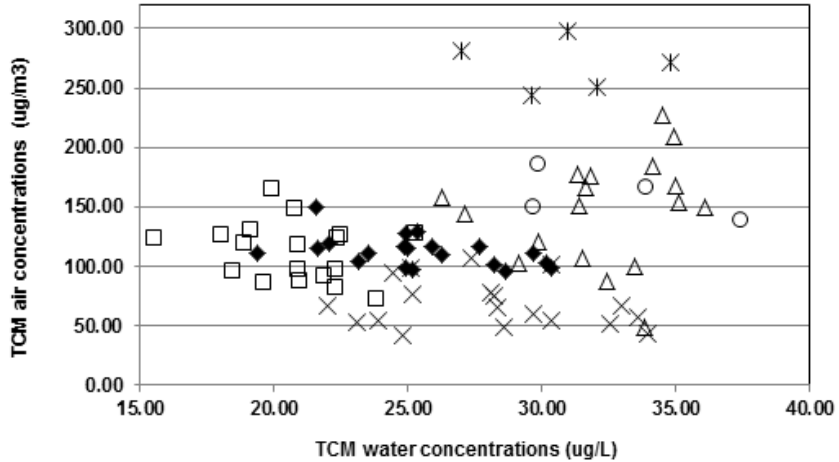
Figure 7. Concentrations (µg/m 3 ) of TCM in the air of [A] and [B] vs. water concentrations